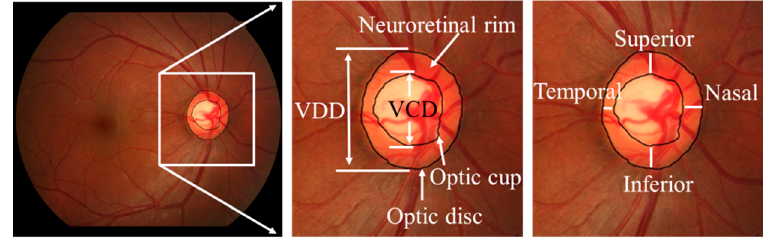
Figure 1. Optic disc, optic cup and neuroretinal rim in a fundus image.